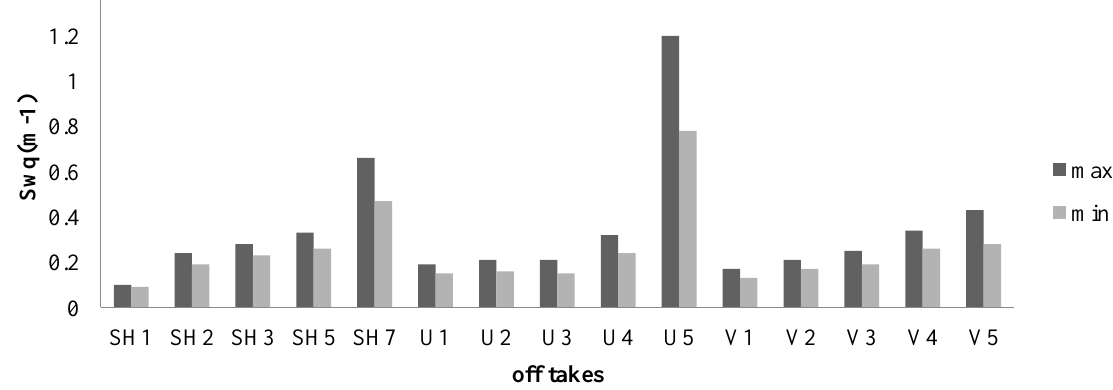
Fig. 9 Offtake sensitivity of delivery to gate opening Index (Calculated